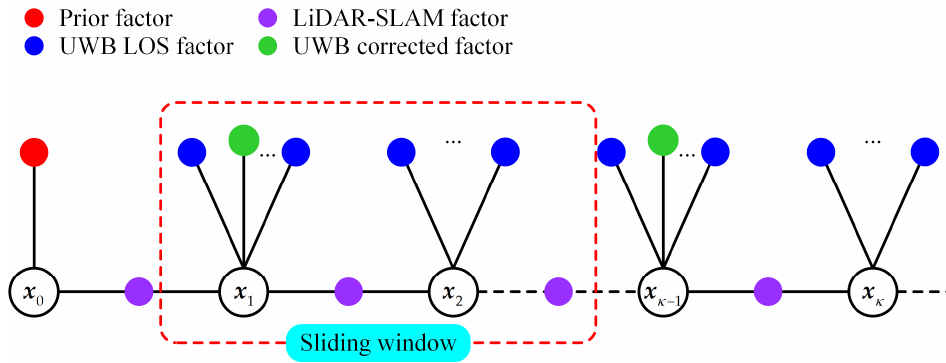
Figure 4. Framework of the FGO-based UWB/LiDAR-SLAM tightly coupled integrated system.